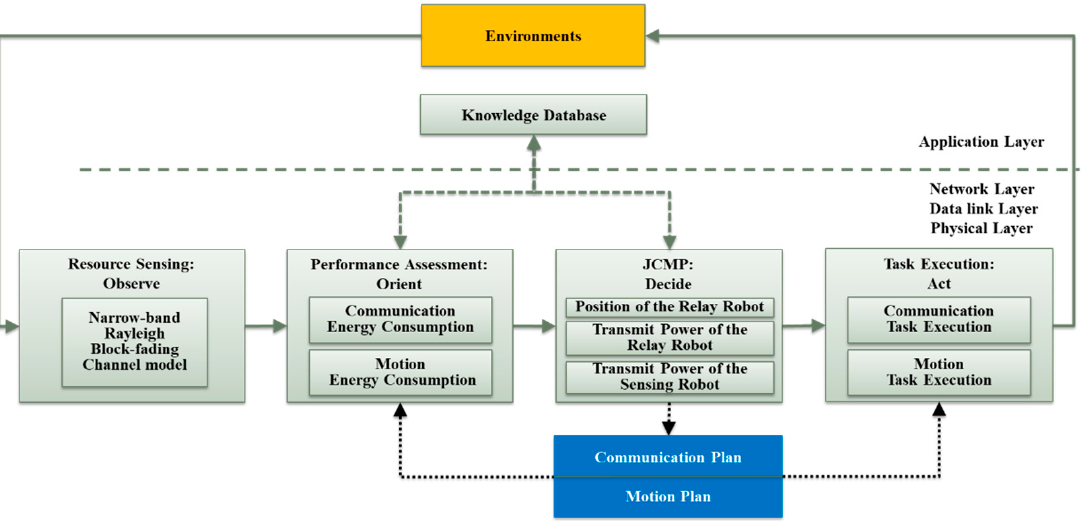
Figure 2. The OODA-based scheme for both conventional relay-assisted robot system (Section 2) the cognitive-relay-assisted robot system (Section 3).